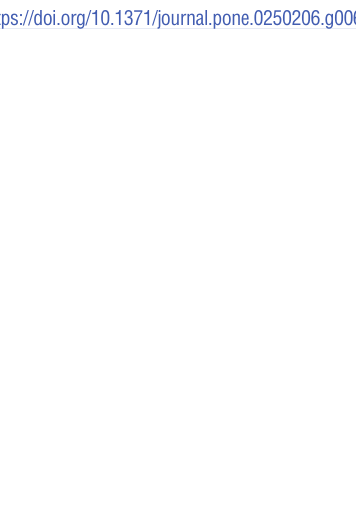
Fig 6. STRUCTURE analysis of the 31 populations based on the genotype data of each